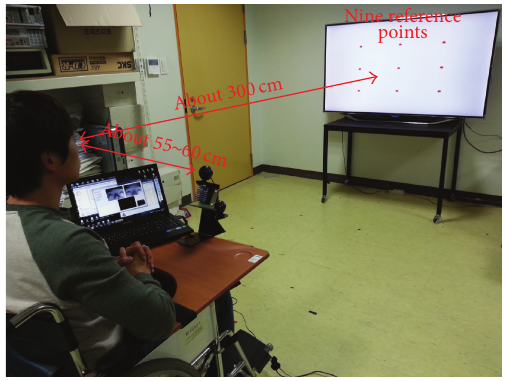
(b), and (c) of Figure 16 look similar because the differ- ence between the near and far 𝑍 -distances (the upper